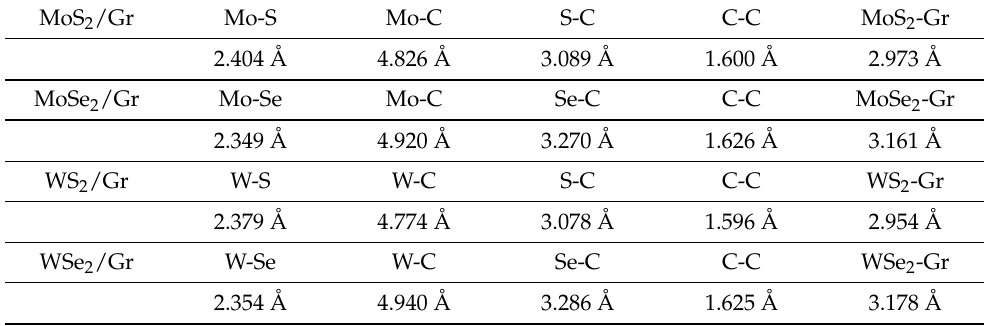
Table 2. The optimized atom–atom distances as well as the MX 2 layer–Gr layer